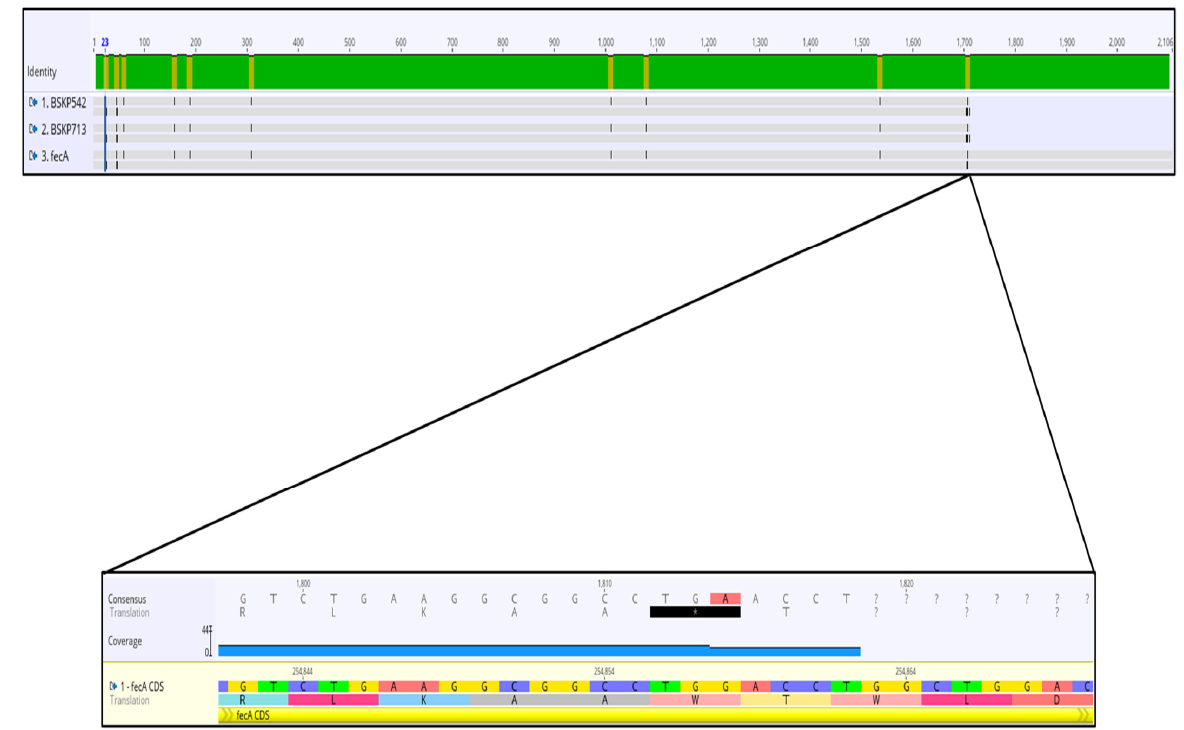
Figure 2. Presence of nonsense mutations in the fecA gene in BSKP713 and BSKP542 isolates. A nucleotide mutation from G to A in position 254,858 generated a TGA stop codon in the fecA gene in both of our isolates.